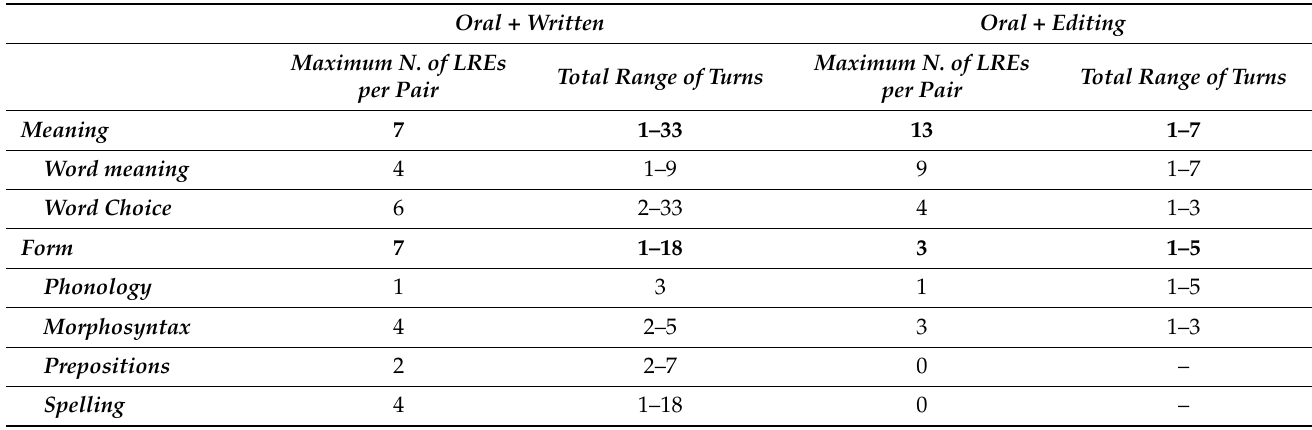
Table 5. Elaboration of the LREs in both